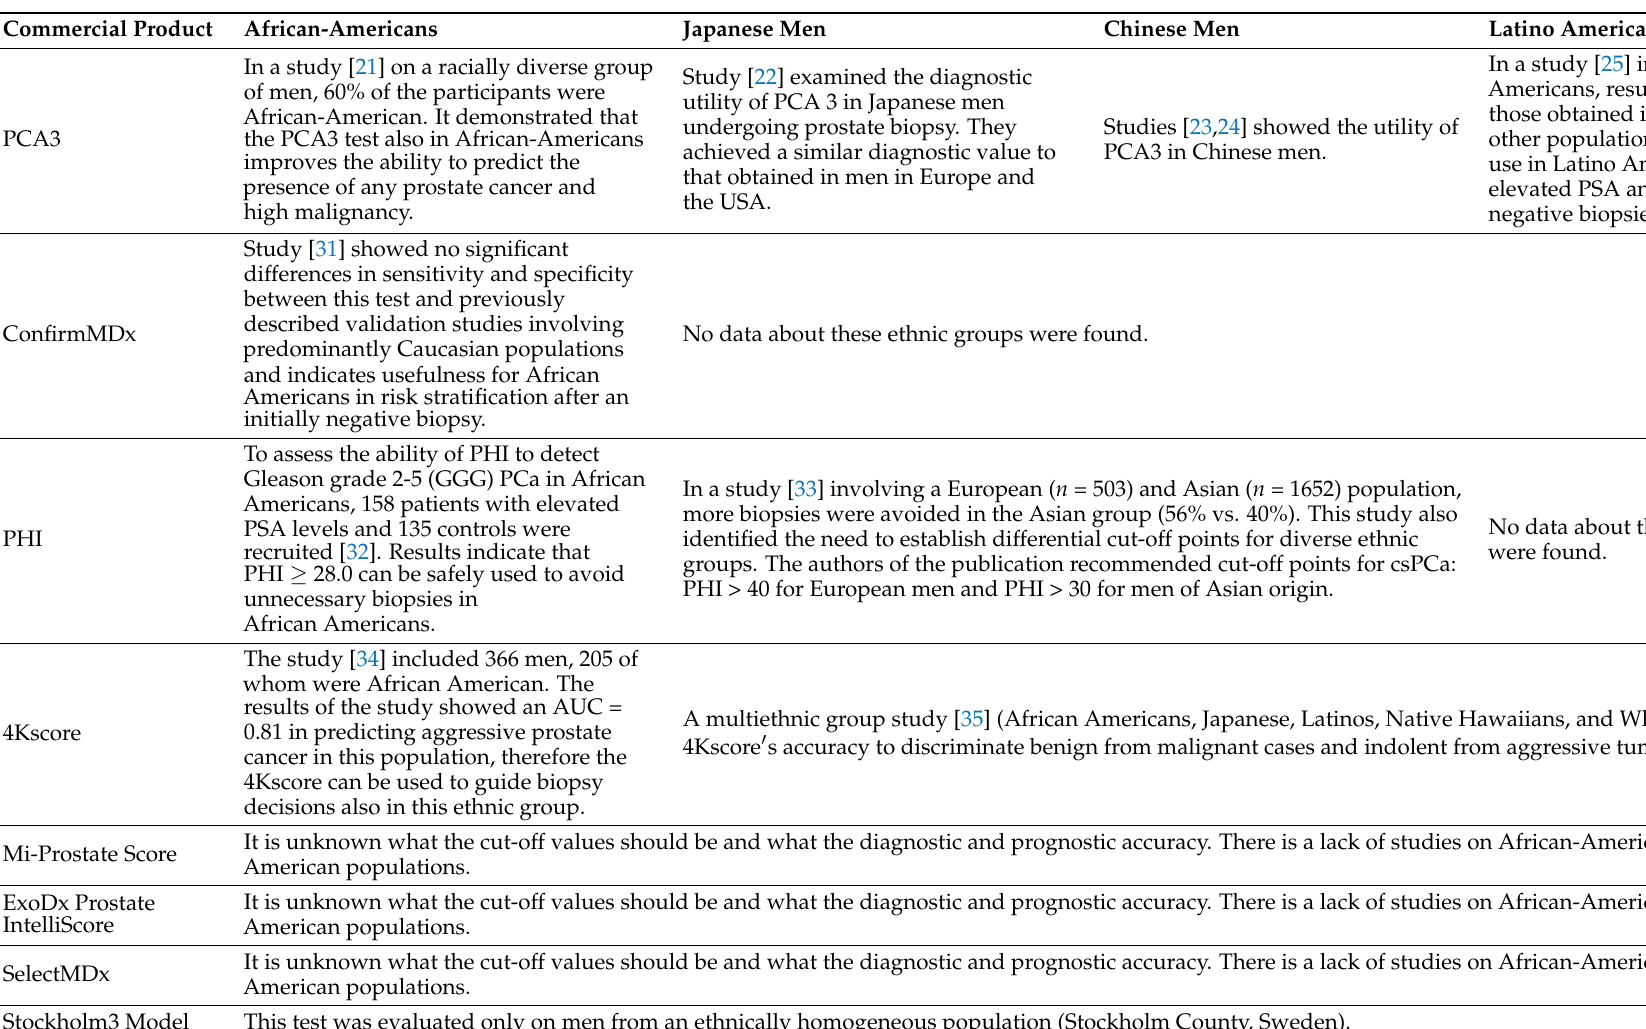
Table 2. Evaluation of biomarkers in multiethnic